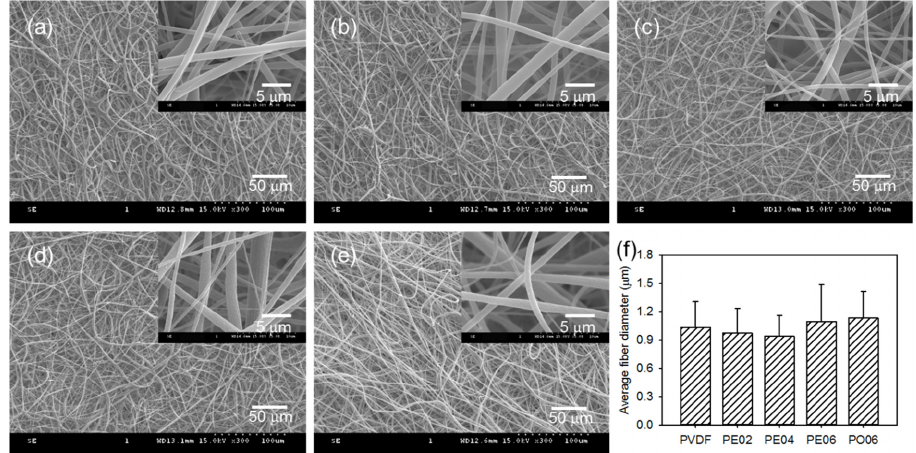
Figure 2. SEM images of ( a ) PVDF, ( b ) PE02, ( c ) PE04, ( d ) PE06, and ( e ) PO06 composite nanofibers. ( f ) Average fiber diameters of the PVDF composite nanofibers analyzed from the SEM images ( n =